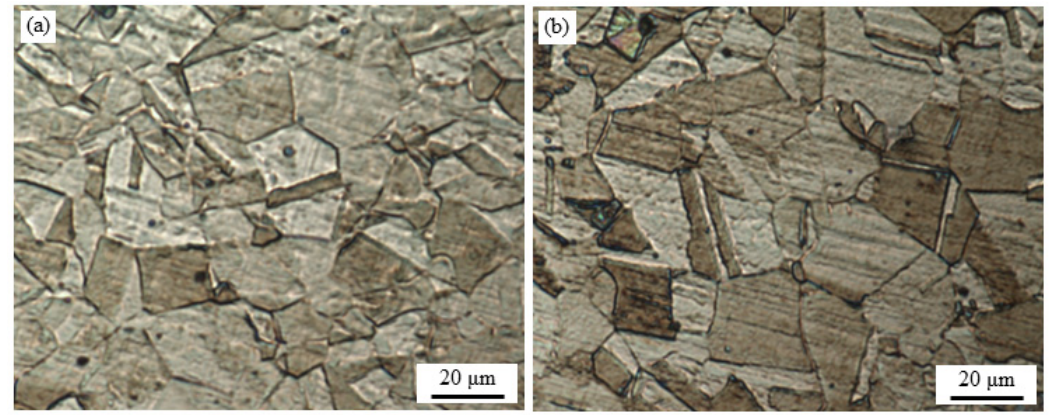
Figure 2. Optical microscopy (OM) micrographs: ( a ) thermo-mechanical processed (TMP), and ( b ) recrystallized Fe − 30Mn − 5Al − 0.5C TWIP steel specimens.